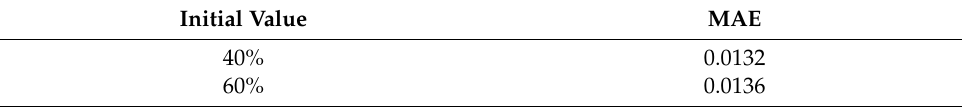
Table 4. MAE and convergence rate at 0 ◦ C.